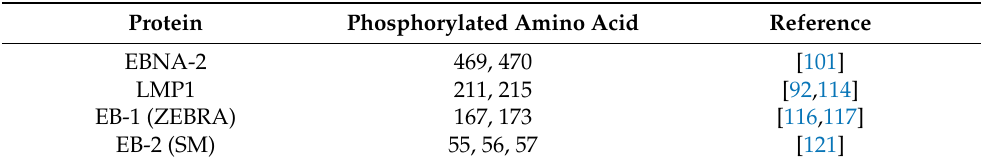
Table 2. CK2 phosphorylation of EBV